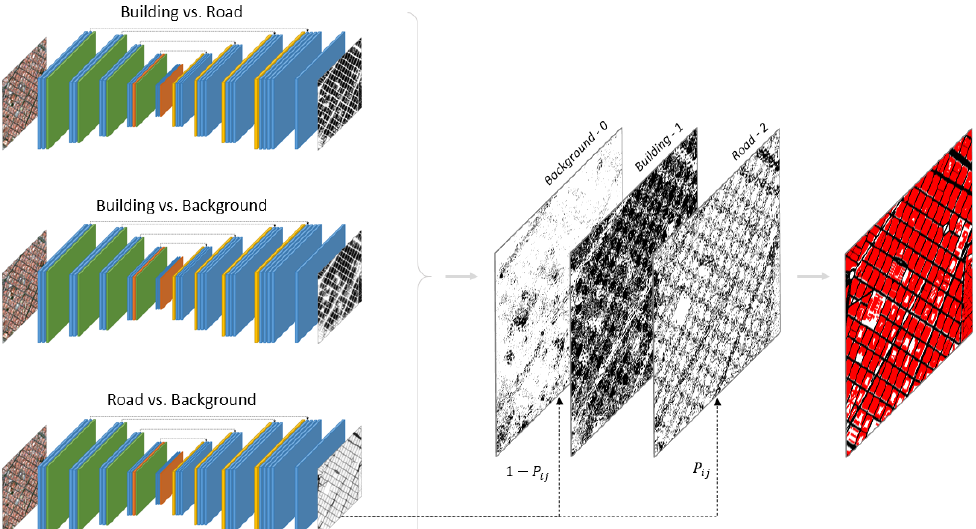
Figure 2. OVO decomposition scheme adapted to a multi-class semantic segmentation problem, including building footprints and road